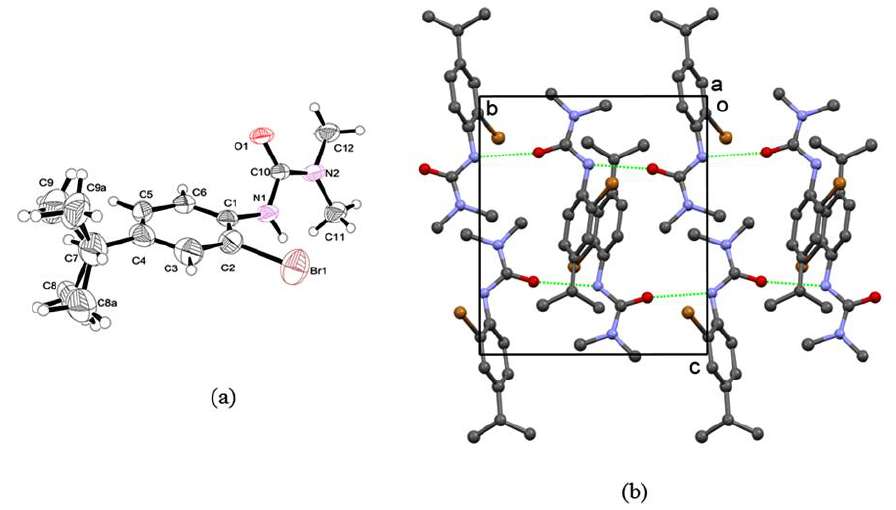
Figure 2. ( a ) An ortep representation of the asymmetric unit of 1 LT showing the disordered isopropyl group; ( b ) Crystal packing viewed down the a axis with hydrogen atoms and one disorder component omitted for clarity. Hydrogen bonds are shown as dashed lines.